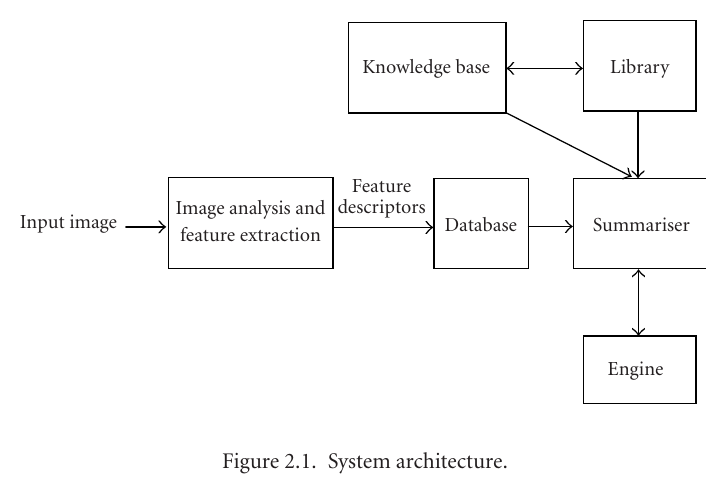
Figure 2.1. System